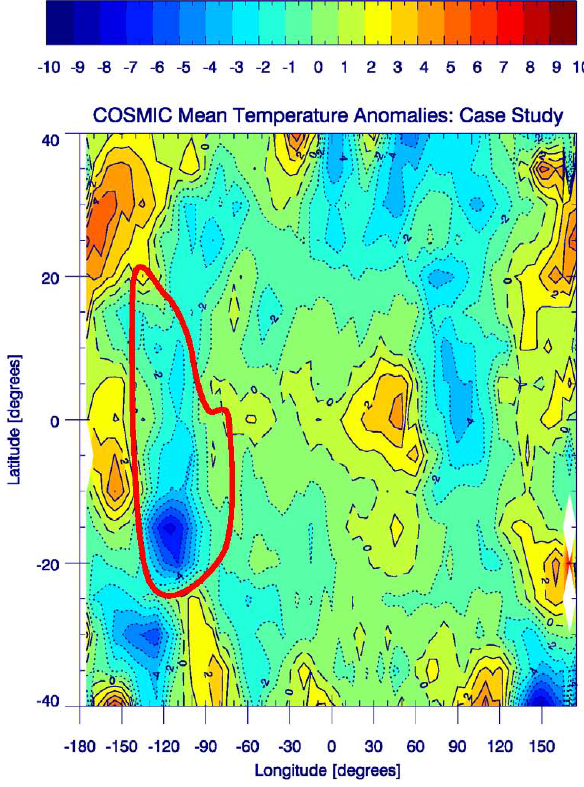
Fig. 8. Temperature anomalies on 27–29 January 2010 on the 16km altitude surface. Anomalies are derived by subtracting the monthly mean temperature.